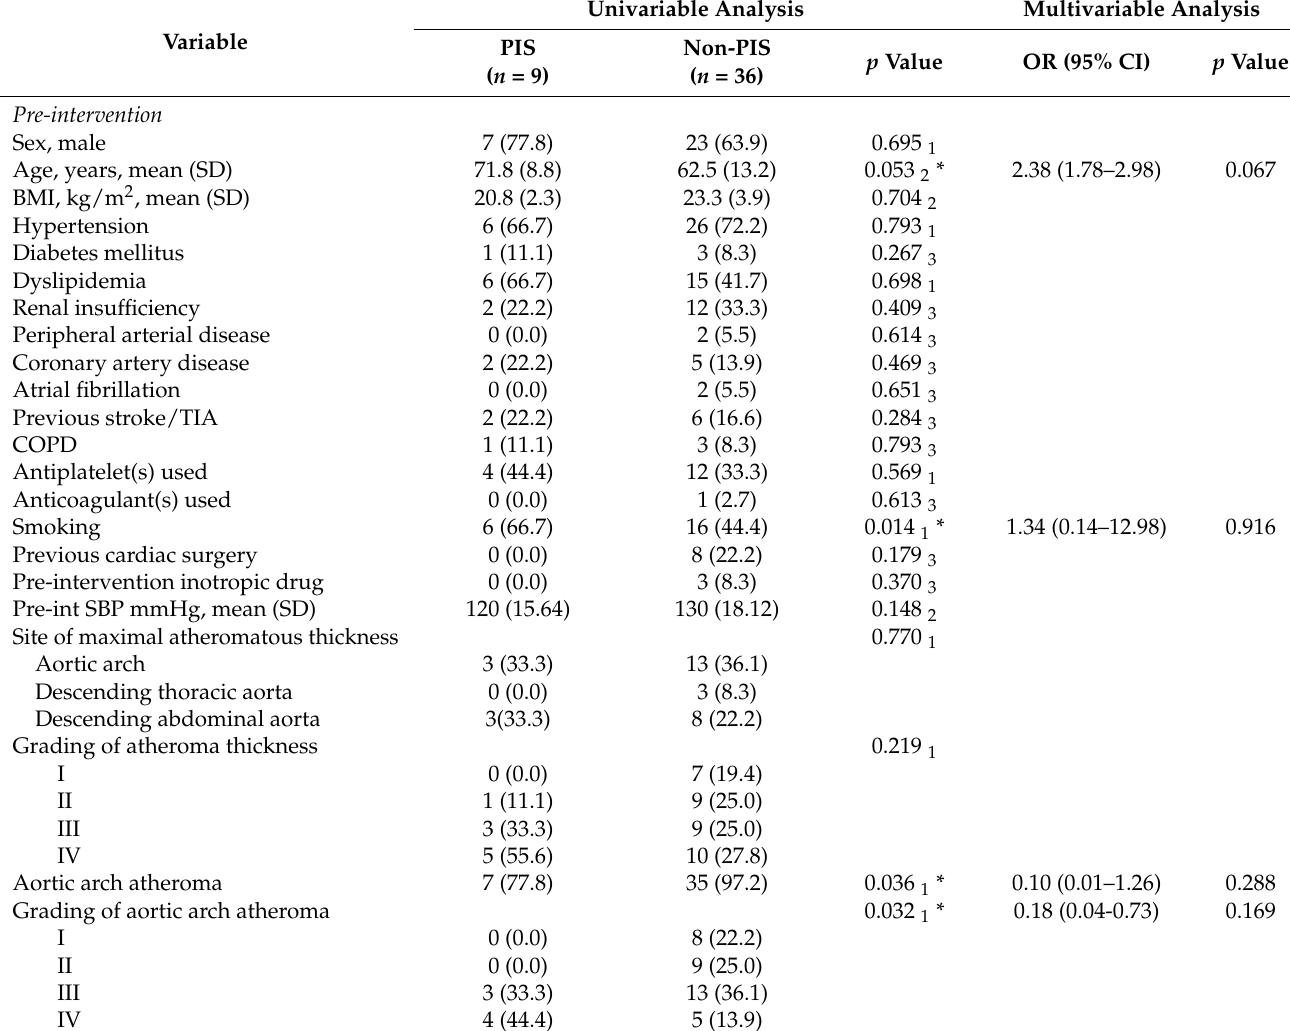
Table 1. Pre-, intra-, and post-intervention risks of TEVAR-related peri-intervention strokes by univariable analysis and multivariable